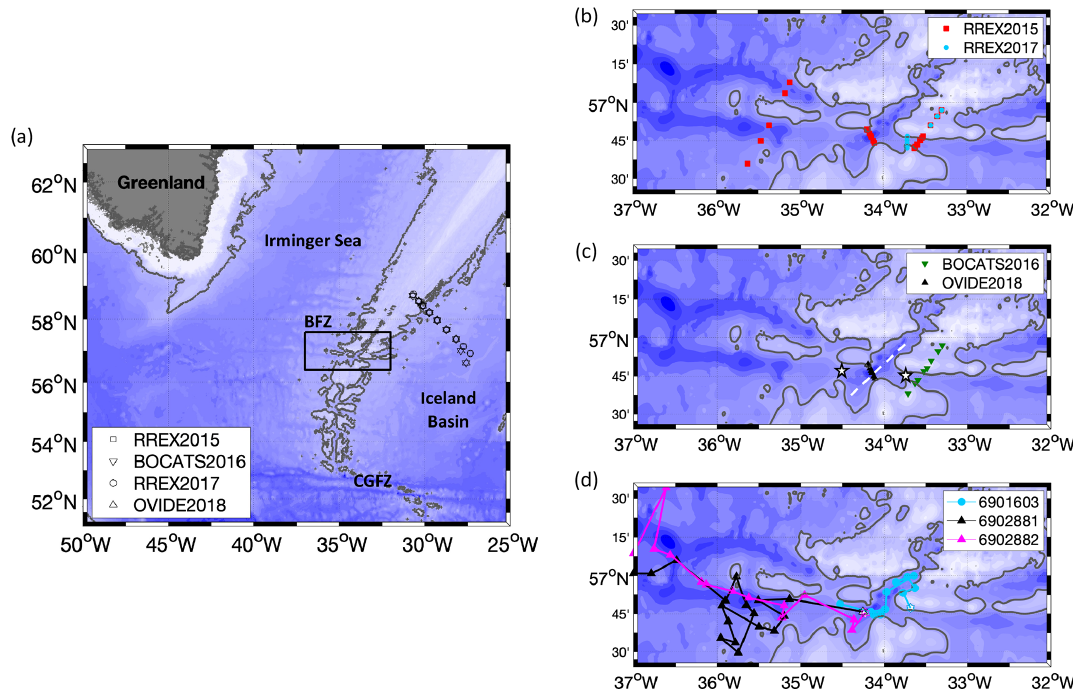
Figure 1. Bathymetry of the Reykjanes Ridge from ETOPO1 with 200m isobaths spacing from white at the surface to dark blue at depth for (a) the eastern subpolar gyre and (b, c, d) the region of the Bight Fracture Zone as identified by the black rectangle in the panel. The gray line outlines the 2100m isobaths. (a) Hydrographic stations realized along the OVIDE line during the RREX15, BOCATS16, RREX17 and OVIDE18 cruises. (b) Hydrographic stations realized in the BFZ during the RREX15 and RREX17 cruises. (c) Hydrographic stations realized in the BFZ during the BOCATS16 and OVIDE18 cruises. The axis of the rift valley of the Reykjanes Ridge crosses the Middle section and is identified by a white dashed line. The eastern and western sills are identified by white stars. (d) Positions of the Deep-Arvor float profiles for 6902881 (cycles 1–14), 6902882 (cycles 1–18) and 6901603. All floats show overall westward trajectories from their deployment position identified by a white